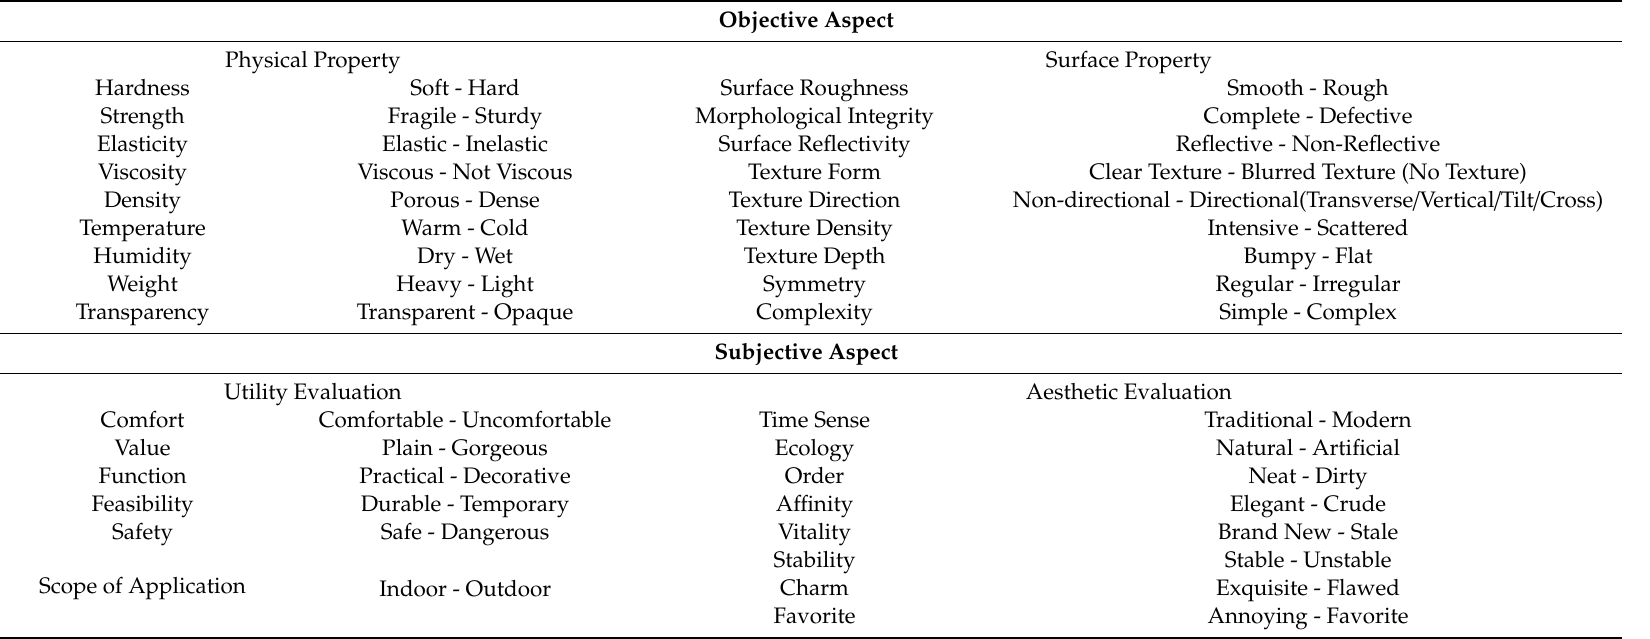
Table 6. Semantic Descriptive Scales for Material Texture in